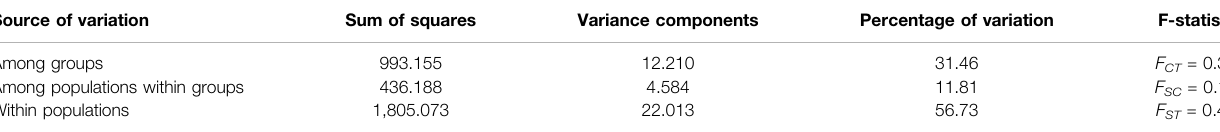
TABLE 2 | Analysis of molecular variance (AMOVA) for the 12 populations of Primulina danxiaensis . Source of